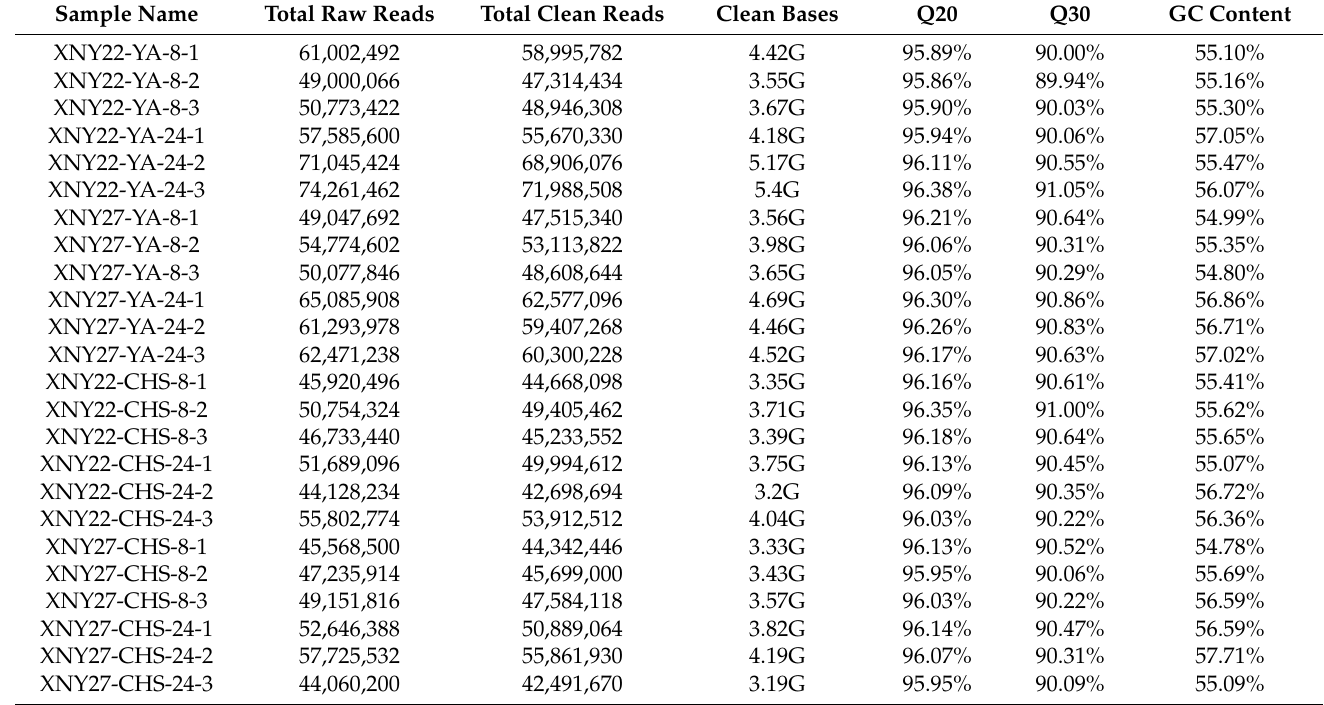
Table 1. Statistical analyses and mapping results of RNA sequencing